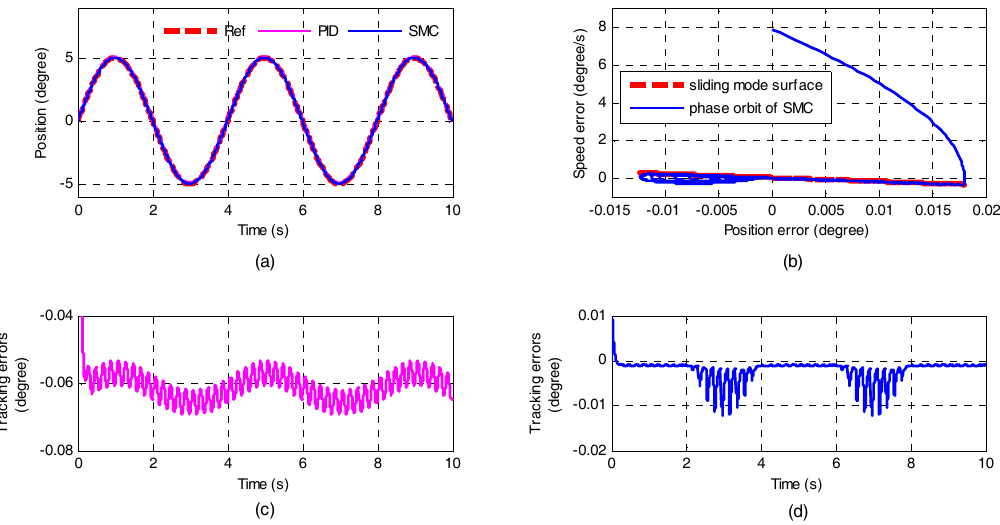
Figure 6. Simulation of sinusoidal response of Joint 1: ( a ) Position tracking; ( b ) Phases trajectory diagram of SMC; ( c ) Tracking error of PID; and ( d ) Tracking error of SMC.